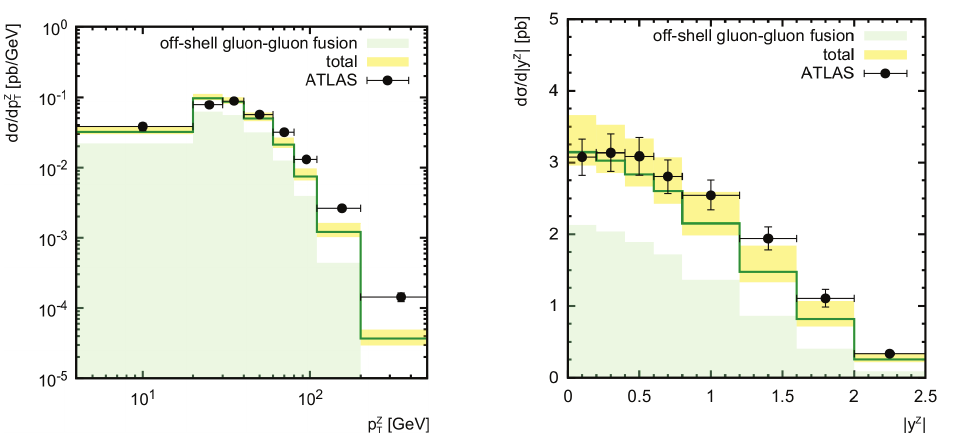
Figure 1. Associated Z + b production cross section at √ s = 7 TeV presented as a function of the Z boson Figure 2. The o ff -shell gluon-gluon fusion contribution to the associated Z + b production at √ s = 7 TeV. The transverse momentum (left panel) or rapidity (right panel). Solid histograms show our predictions at the default data are from ATLAS scale while shaded bands correspond to scale variations described in the text. The estimated DPS contributions and MCFM [28] predictions (taken from [3]) are shown additionally. The data are from ATLAS [3]